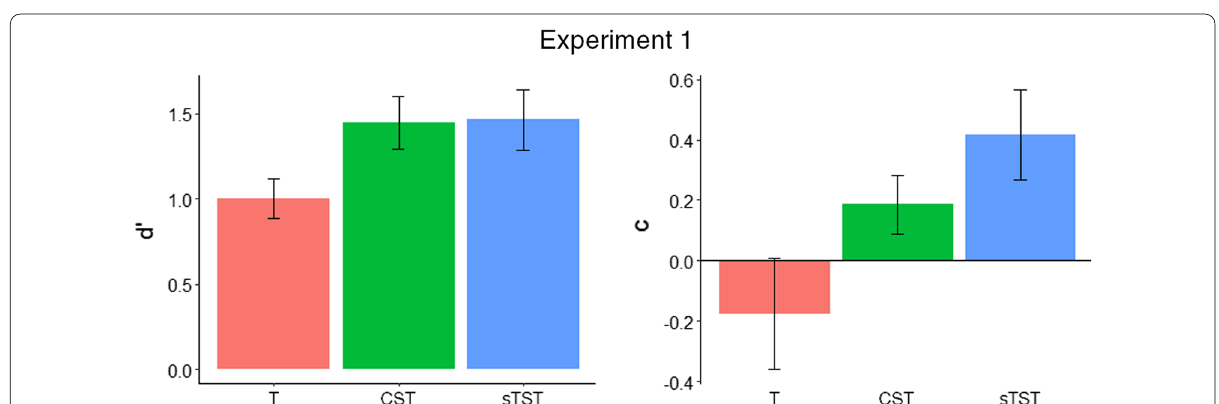
Fig. 3 d ′ and c for the target‑based search training (T), standard targetless search training (sTST) and combined search training (CST) groups in Experiment 1 (error bars show 95%